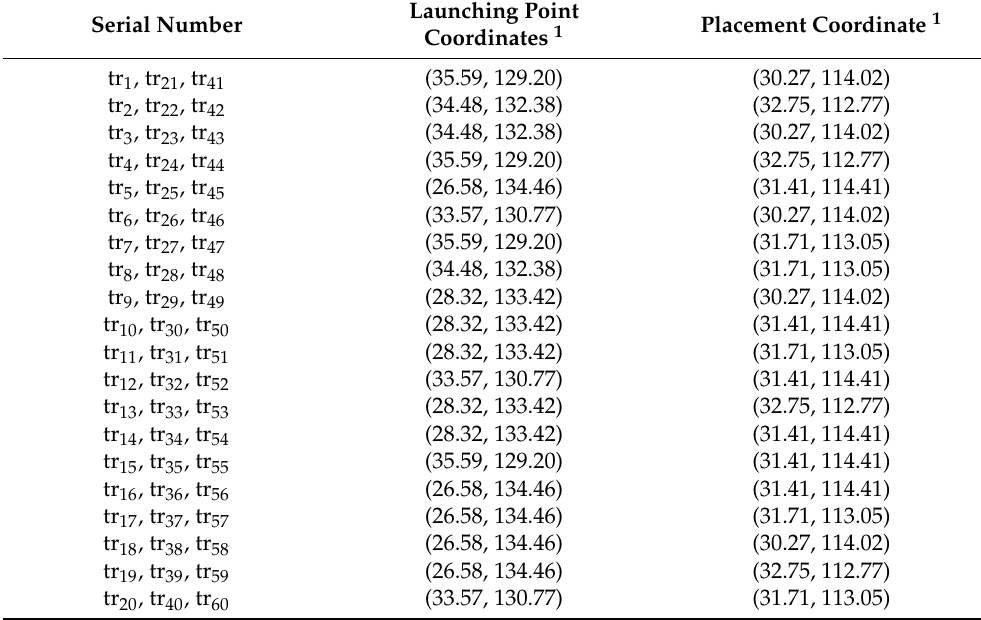
Table 9. Incoming target